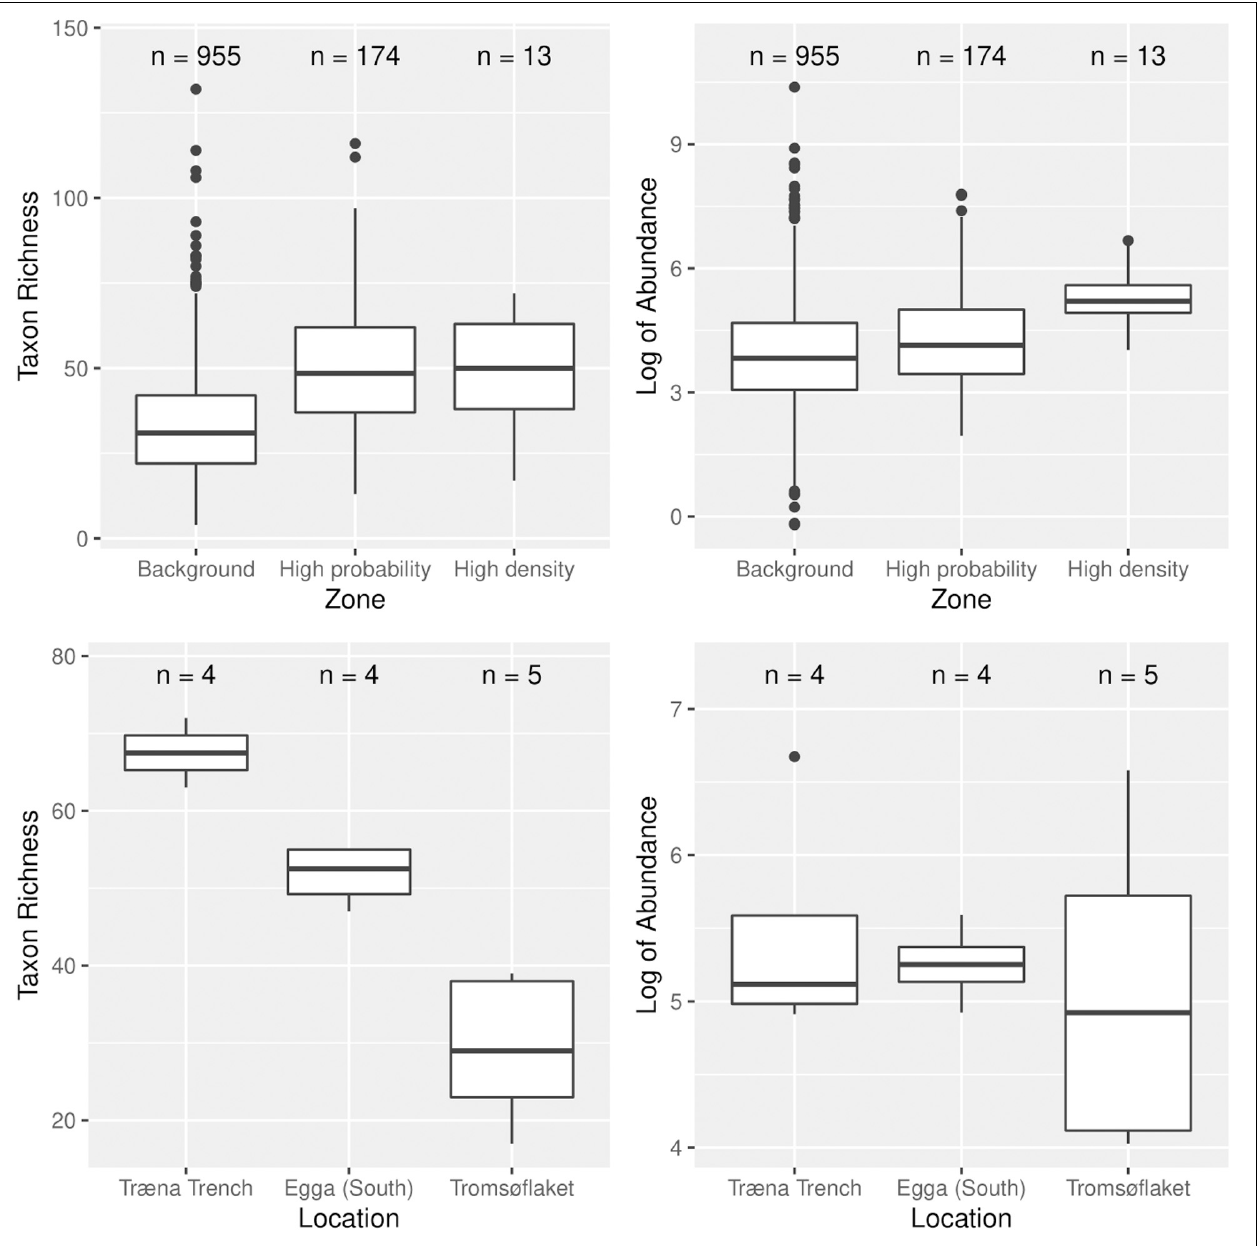
FIGURE 5 | Boxplots illustrating patterns in epibenthic megafaunal taxon richness, and total abundance of epibenthic megafauna (which was log-transformed) in relation to the predicted distribution of soft-bottom, deep-sea sponges. On the top plots we compare these parameters (namely richness and abundance) in relation to a “gradient” toward the areas of highest predicted sponge density. The three zones compared are “background” (low probability and low density), “high probability” (probability above 0.75 and density below 13 n/100 m 2 ) and “high density” (the four identified hotspots). On the bottom plots we compare richness and abundance among three of the four hotspots (one of them did not have any sampling stations within). Also included are the number of stations in each group. Note that the bottom plots represent the variation among the 13 samples in the high-density zone (see the plot